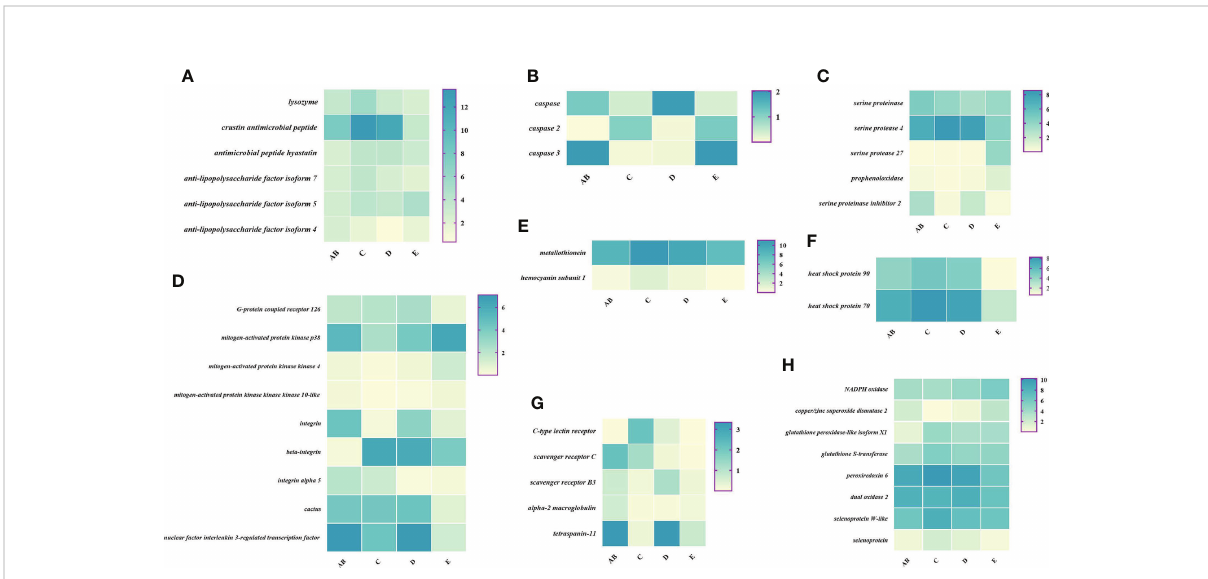
FIGURE 7 Expression patterns of immune-related genes in the hemolymph during the molting cycle of P. trituberculatus . (A) The genes related to antimicrobial peptides; (B) the genes related to apoptosis; (C) the genes related to prophenoloxidase cascade; (D) the genes related to signal transduction; (E) the genes related to other immune molecules; (F) the genes related to chaperones; (G) the genes related to pattern recognition proteins/receptors; (H) The genes related to antioxidative enzymes system. Notes: (1) The x -axis shows the molting stages, whereas the y -axis represents the name of genes. (2) The color represents the expression level of the gene; the darker the color, the higher gene expression level. (3) The expression level of immune-related genes was shown as log 2 transcript per million plus one (TPM +